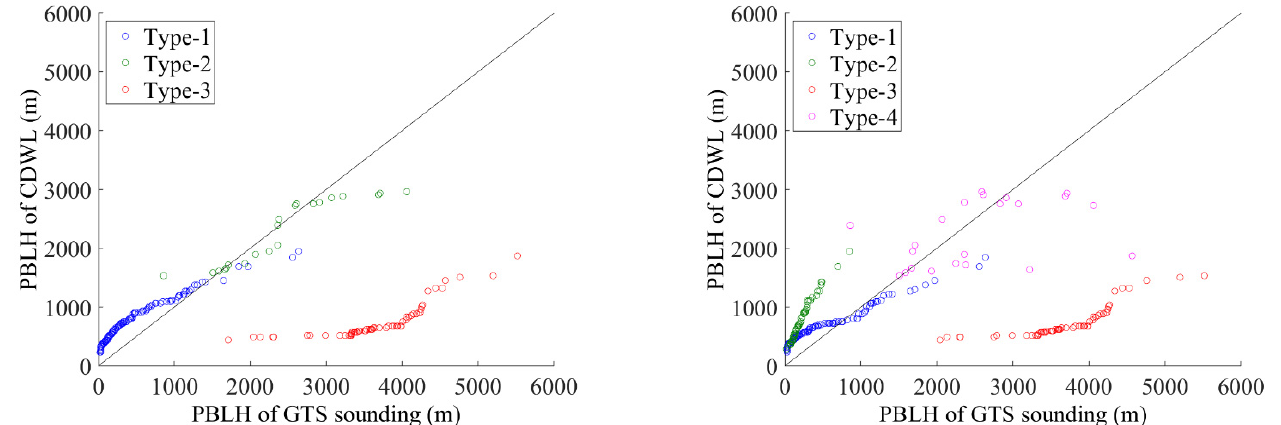
Figure 5. Quantile–quantile plot of the inversion of the PBLH of CDWL and GTS soundings after k-means clustering into three ( left ) and four ( right ) types.